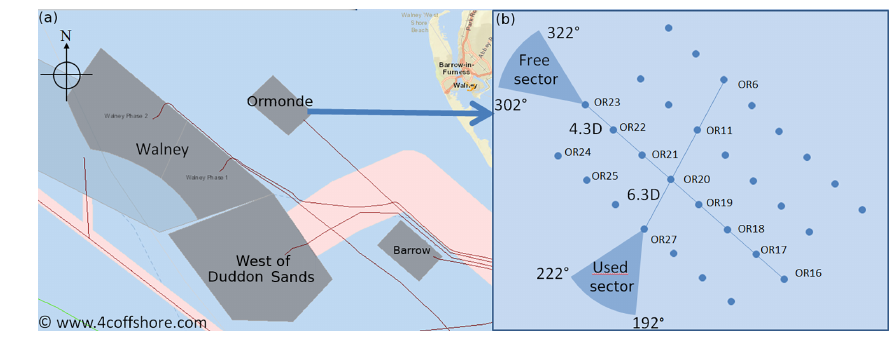
Figure 3. (a) Ormonde and neighbouring wind farms. (b) Ormonde wind farm layout with distances in rotor diameters (D) and sectors selected for the analysis.